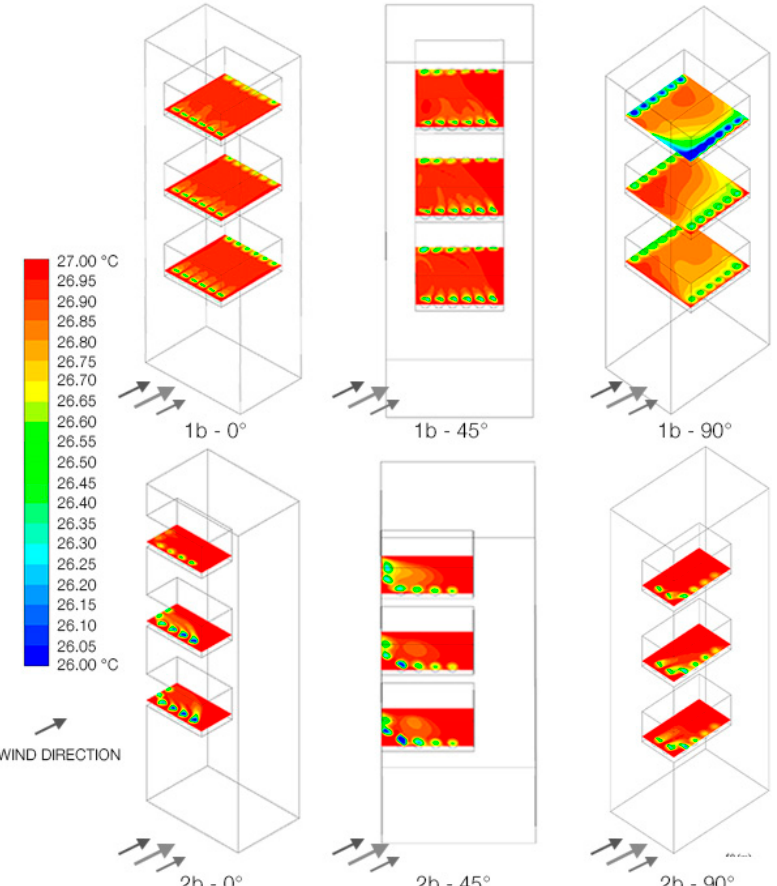
Energies 2019 , 12 , x FOR PEER REVIEW 30 of 34 Figure 19. Temperature gradient at sky garden with trees when wind flows obliquely to the building; (1a) Central sky garden b/B = 0.4, (1b) Central sky garden b/B = 0.6, (1c) Central sky garden b/B = 0.8, (2a) Corner sky garden b/B = 0.4, (2b) Corner sky garden b/B = 0.6, (2c) Corner sky garden b/B = 0.8, (3a) Periphery sky garden a/A = 0.5